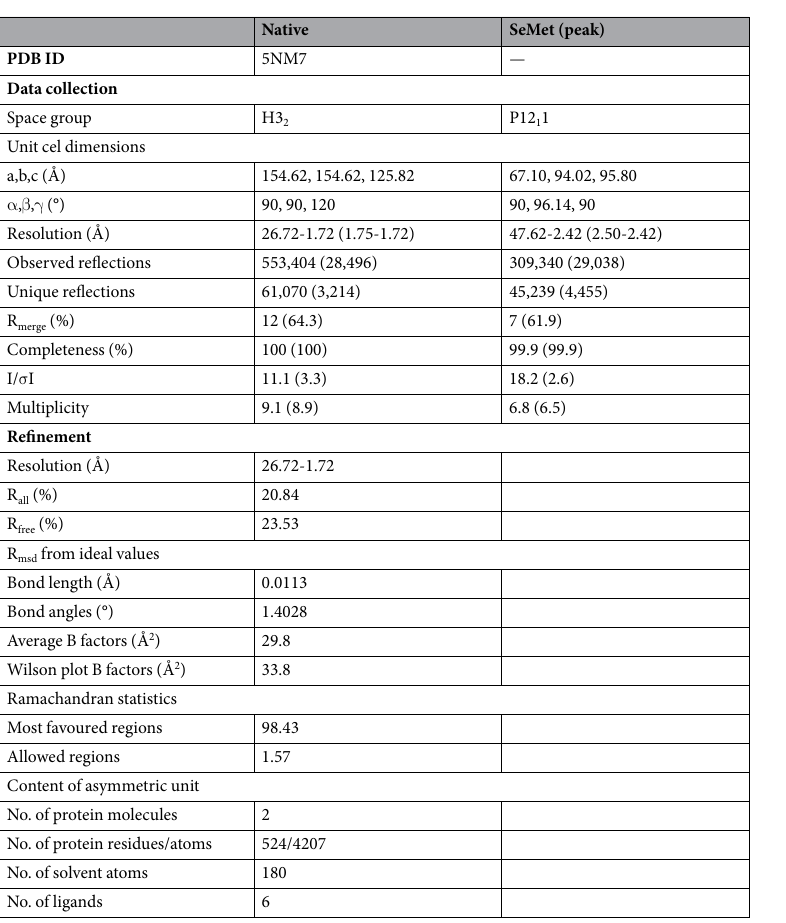
Figure 1. The modular structure of AP3gp15: blue, grey and red colours represent the CBD, hinge region and EAD (DUF3380), respectively. ( A ) The amino acid sequence comparison of AP3gp15 and 10gp110: the active residue Glu (E) at the position 101 is in black and framed; the Asp (D) at the position 110 in AP3gp15 (black) and its equivalent Thr (T) in 10gp110 (red) are framed. ( B ) Two asymmetrical domains are visible, CBD (N-terminal bundle of three helices representing the putative PG binding domain) encompassing residues Lys3 – Ser66; the catalytic domain EAD (residues Asp77 – Ala264); the hinge region (residues Ala67 to Thr76) connects both subunits.